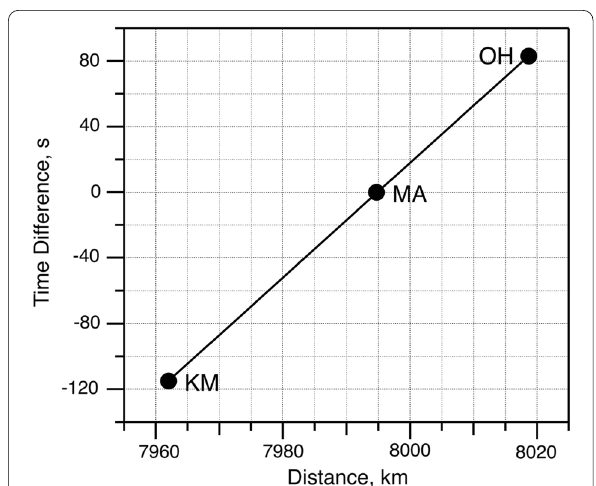
Fig. 3 Time difference of pressure wave trains recorded at barometer stations with respect to Matsushiro, as a function of the distance from the Tonga